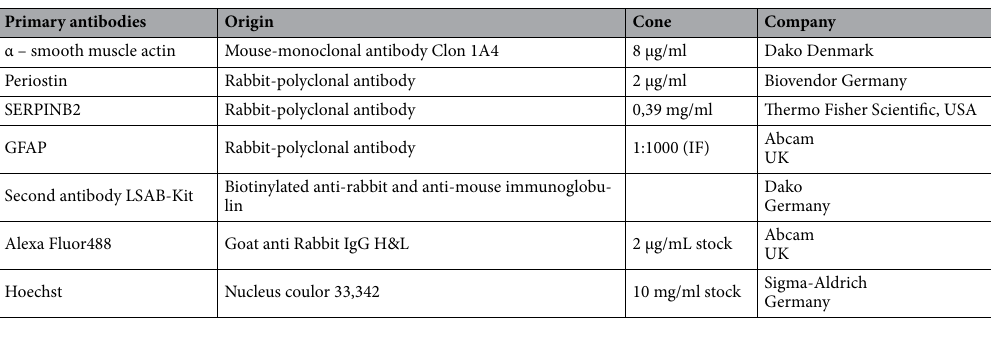
Table 1. List of the used